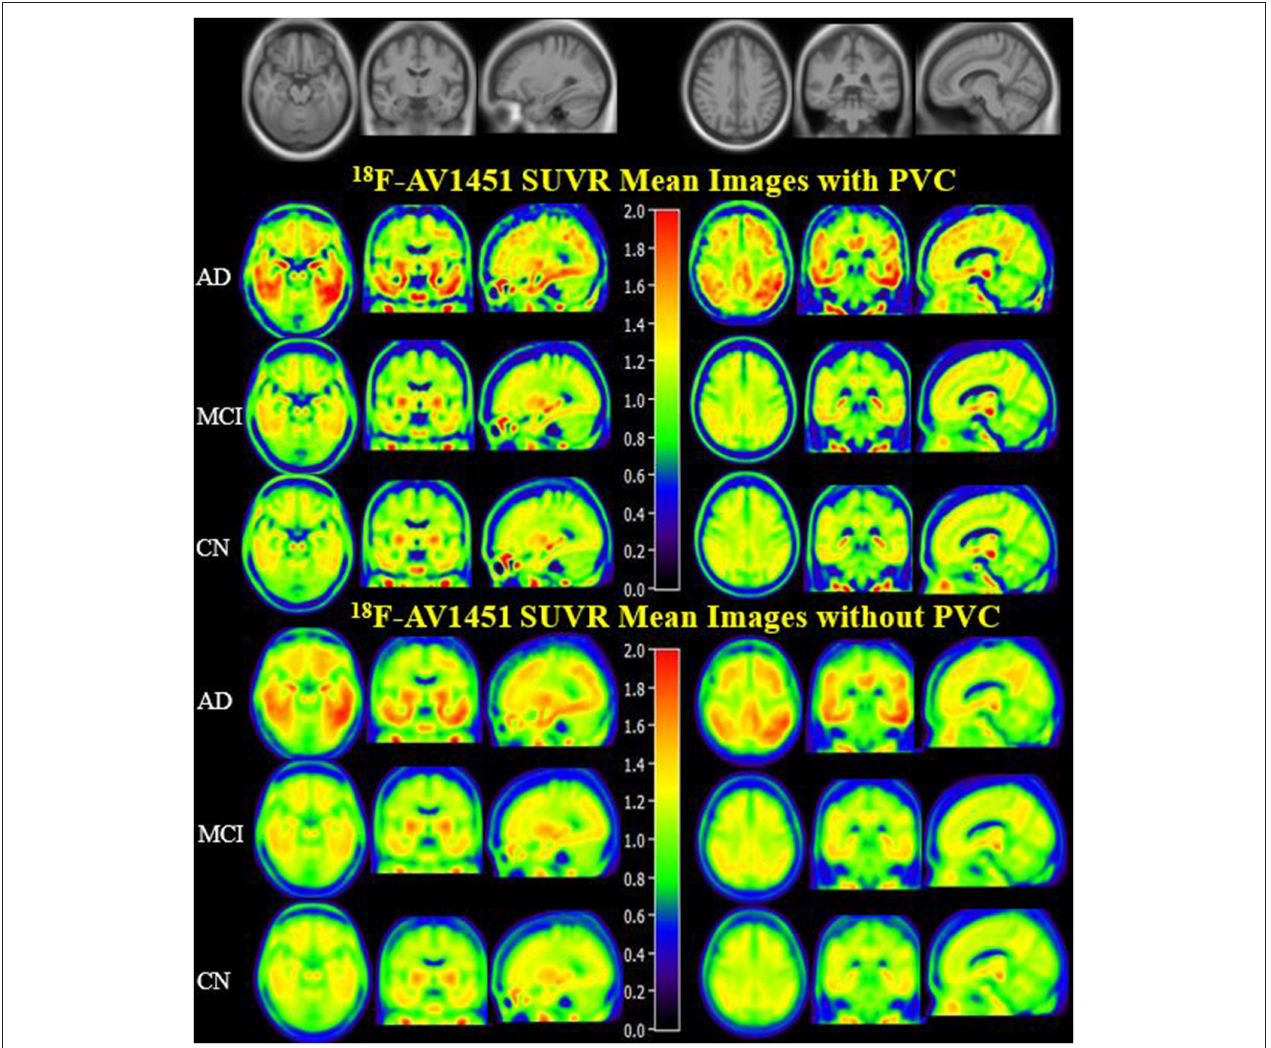
FIGURE 1 | 18 F-AV1451 SUVR Mean Images with PVC and non-PVC. Mean images generated by computing the mean of images from AD, MCI, and CN participants separately. The upper images have been corrected with PVC, whereas the lower images without PVC.